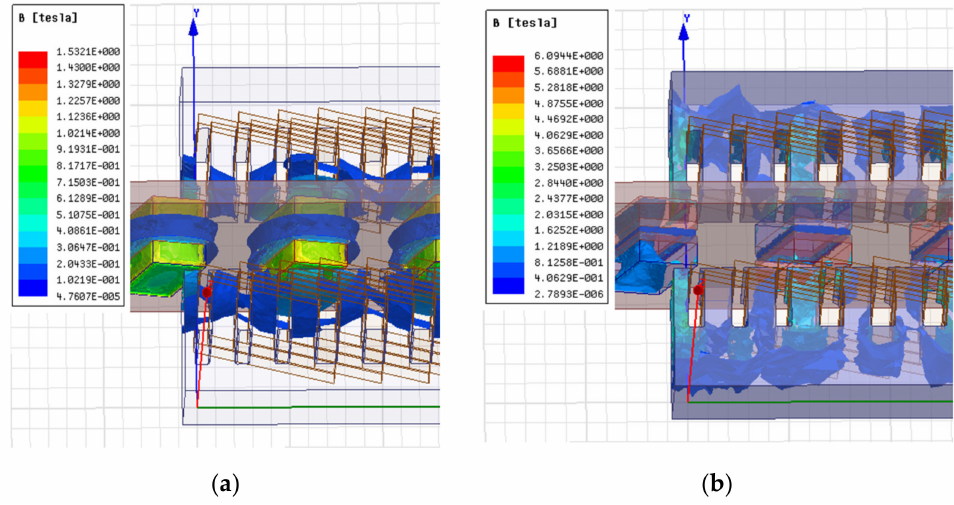
Figure 3. Comparison of the magnetic field distribution: ( a ) ironless stator; ( b ) iron stator.